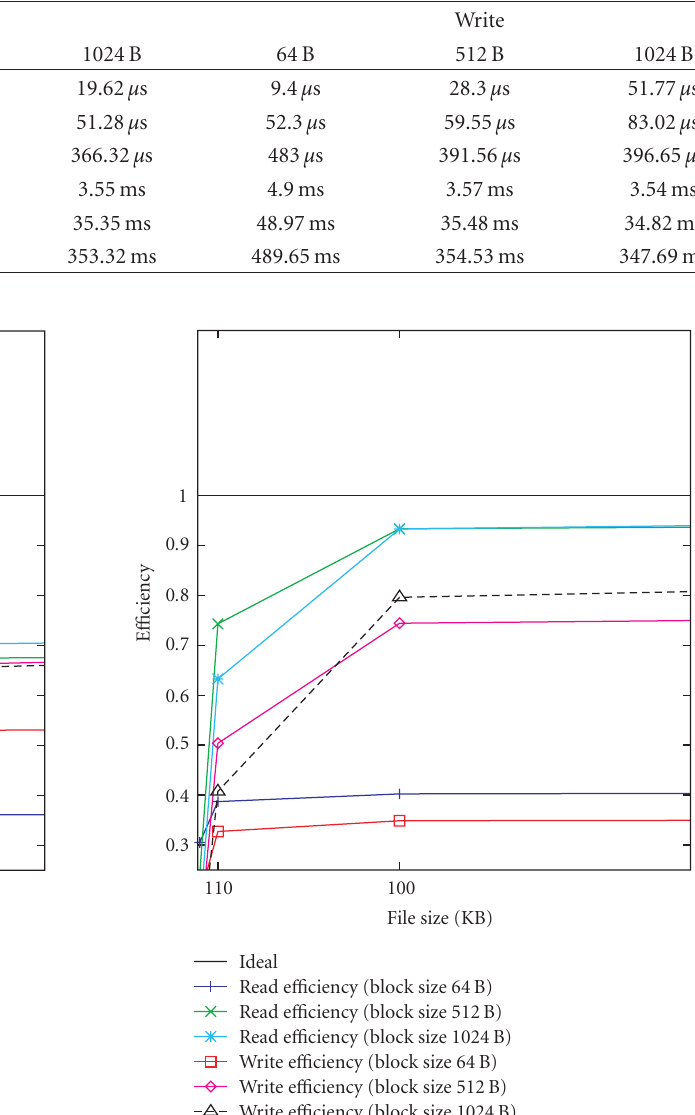
Table 4: Hardware filesystem read/write execution time with single RAM Disk synthesized for the XC4VFX60.